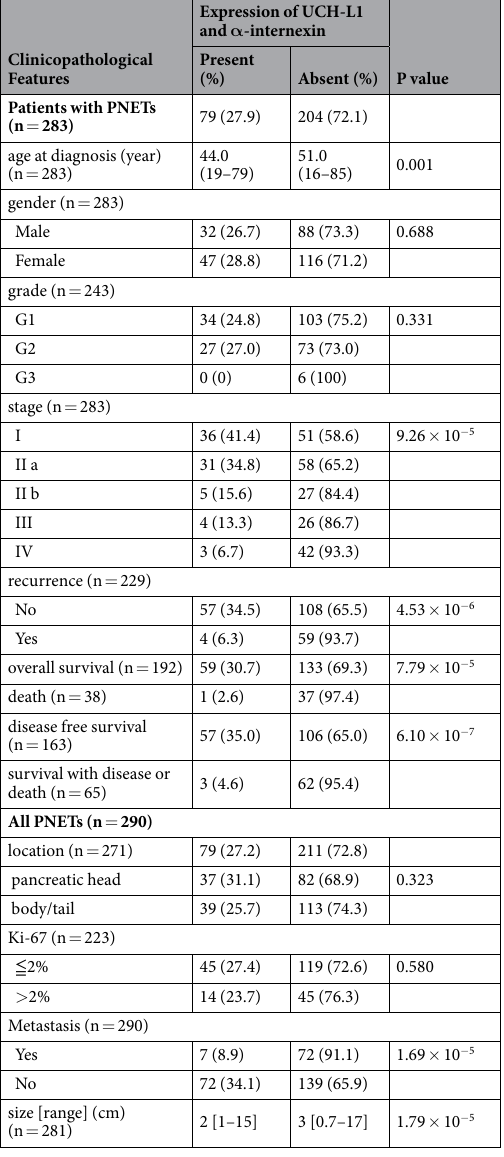
Table 4. Correlation of Clinicopathological Characteristics with Expression of UCH-L1 and α